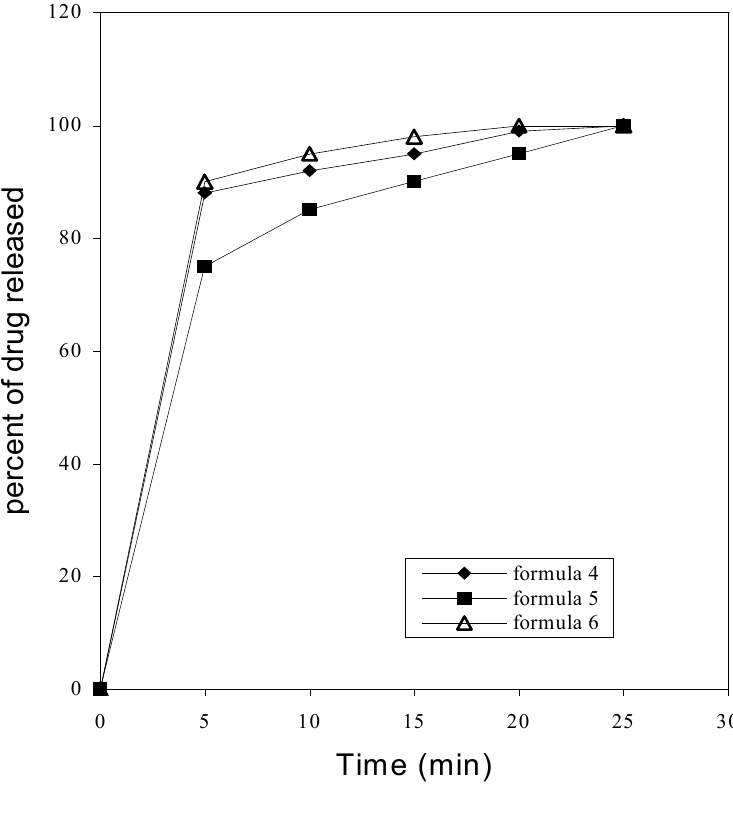
Effect of binder concentration on the release of captopril from suggested formulas 4,5 and 6 in 0.1N